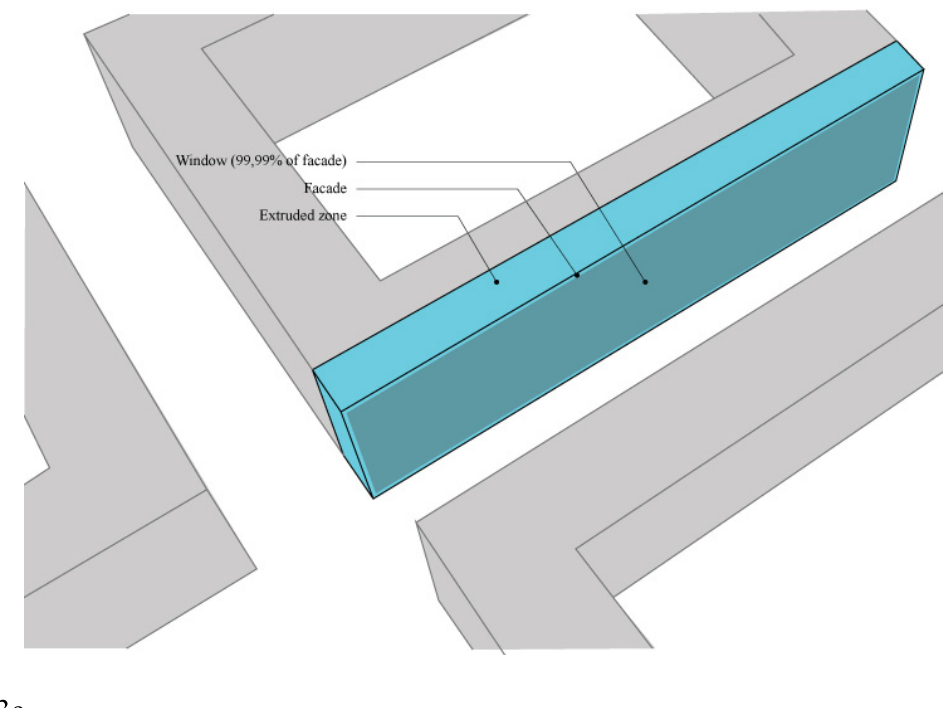
Figure 2. Construction of EnergyPlus